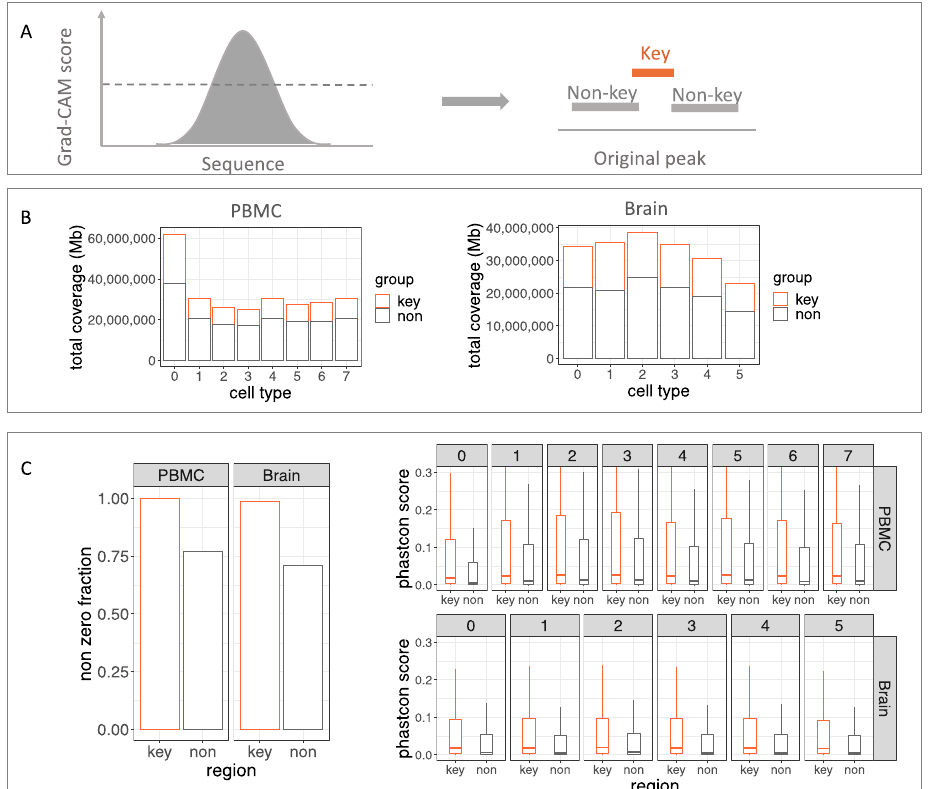
Figure 4. scEpiLock object detection module on the PBMC scATAC-seq data ( A ) Key regions with high Grad-CAM scores are selected. ( B ) Key region and non-key region coverage. ( C ) Nonzero PhastCons scores' fractions between key and non-key regions; PhastCons scores’ comparison between key and non-key regions for each cell type.